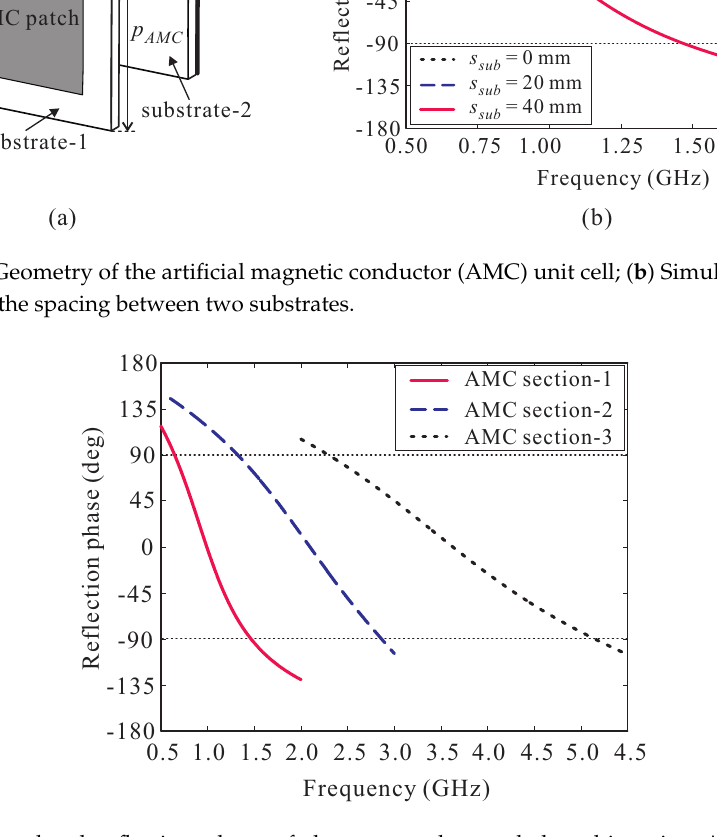
Figure 5. Simulated reflection phase of the proposed cascaded multi-section AMC structure. AMC section-1: p AMC 1 = 70 mm, w AMC 1 = 48 mm, h AMC 1 = 43.04 mm. AMC section-2: p AMC 2 = 35 mm, w AMC 2 = 21 mm, h AMC 2 = 23.04 mm. AMC section-3: p AMC 3 = 35 mm, w AMC 3 = 14 mm, h AMC 3 = 13.04